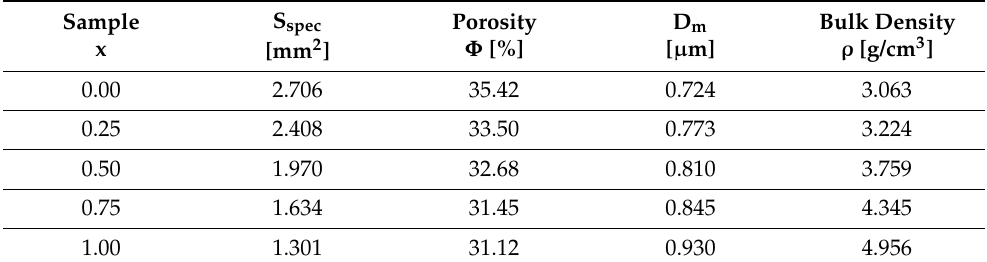
Table 1. Evolution of some intrinsic parameters for Al 1 − x Sb x FeO 3 perovskite.